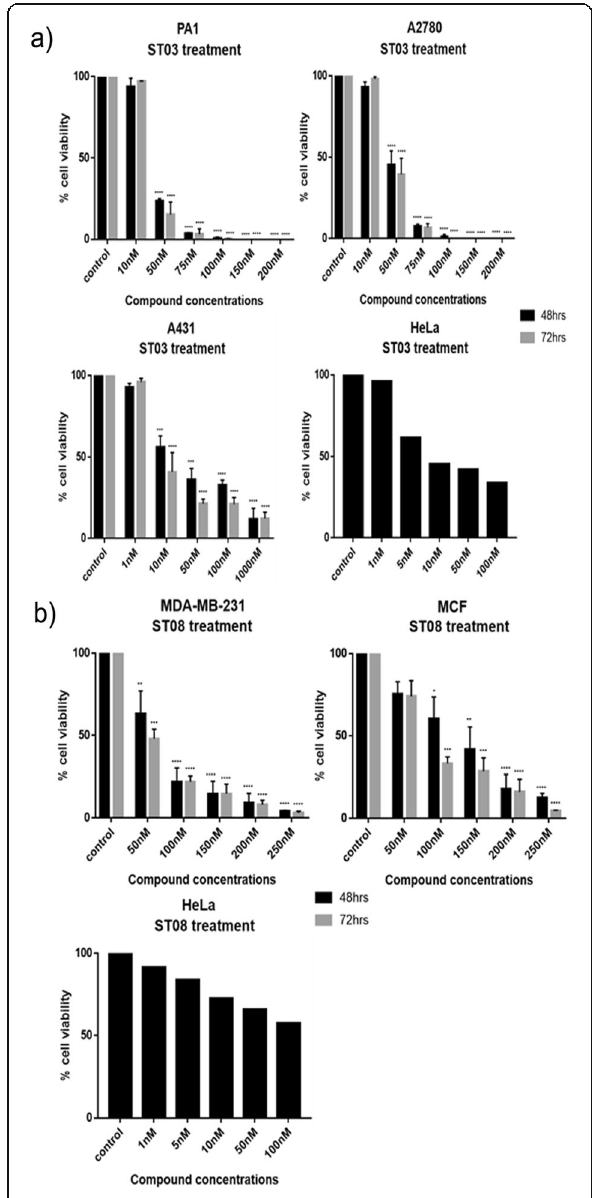
Fig. 4 Examination of the effect of ST03 and ST08 compounds on cancer cell lines by LDH assay. a ST03 treatment on PA1, A2780, A431, HeLa and b ST08 treatment on MDA-MB-231, MCF-7, HeLa. Each experiment was repeated for a minimum of 3 times and plotted as bar graphs with error bars. Two-way ANOVA was conducted using Graph pad prism 7 tool and the p value was calculated between control and ST treated groups, where,*: p value < 0.05, **: p value < 0.005, ***: p value < 0.0001, ****: